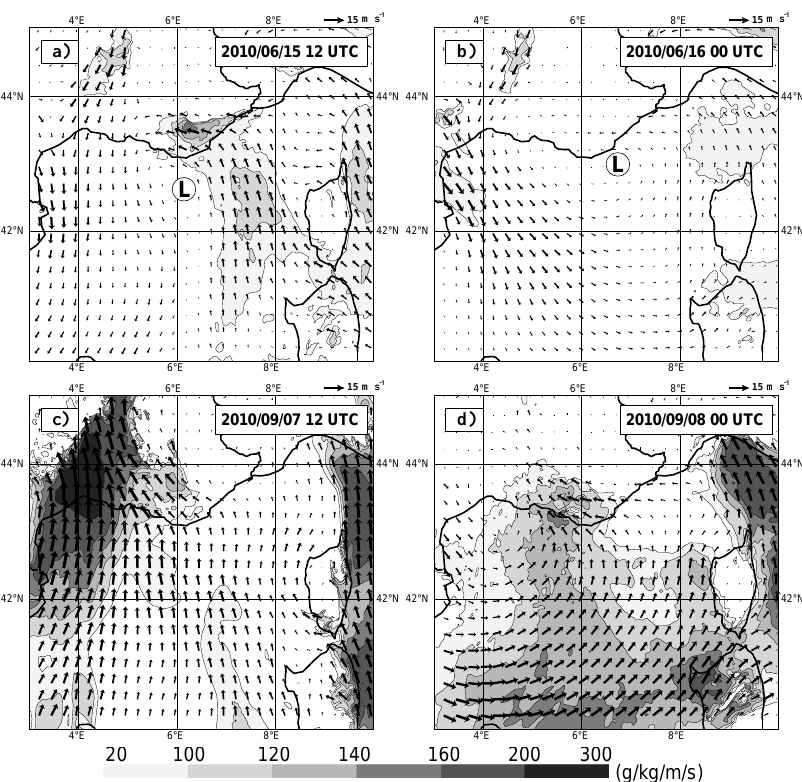
Fig. 10. 925-hPa horizontal moisture flux magnitude (shading, g kg − 1 m s − 1 ) and wind vectors (m s − 1 ) ensemble-mean for the Var case (panels a) and b) ) and the Gard-Ard`eche case (panels c) and d) ), respectively. Ensemble experiments shown are REF in both cases. Initial times of the forecasts are 00 UTC of 15 June 2010 for the Var case and 00 UTC of 07 September 2010 for the Gard case, respectively.